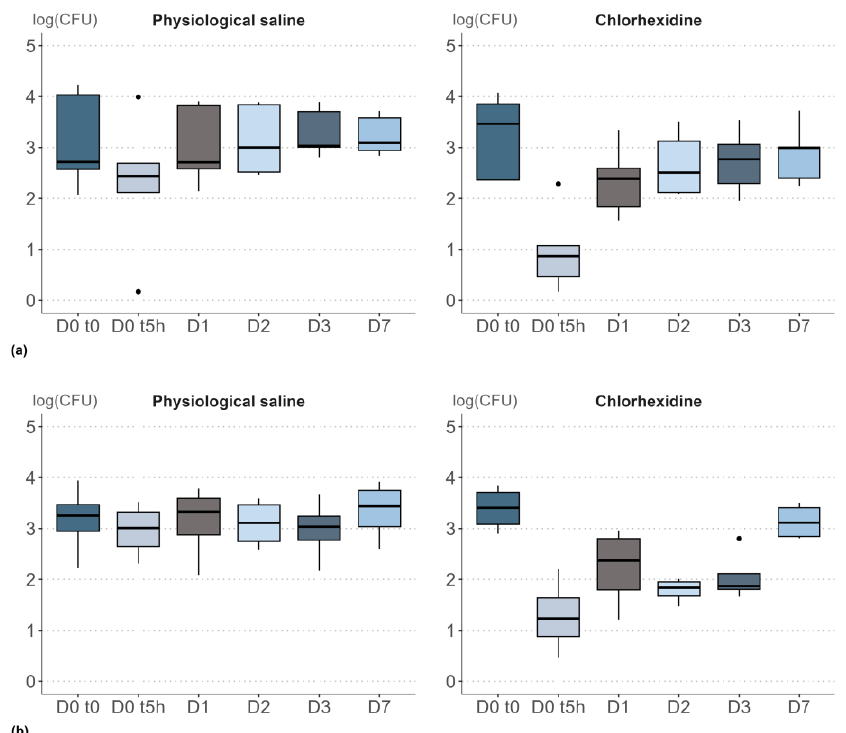
Figure 2. Contrasting effects of a single application of physiological saline and chlorhexidine. Boxplot visualization of the impact of topical applications on bacterial density (CFU/cm²) expressed on log-scale: ( a ) Study 3: impact of a single application of physiological saline or chlorhexidine, ( b ) Study 4: impact of six applications (from D0 to D2) of physiological saline or chlorhexidine. In the boxplot, the dots represent the outliers. The outiliers are defined as the values below Q1 − 1.5 IQR and the values above Q3 + 1.5 * IQR; Q1 and Q3 are the first and the third quartile, respectively, IQR is the interquartile range (Q3–Q1).